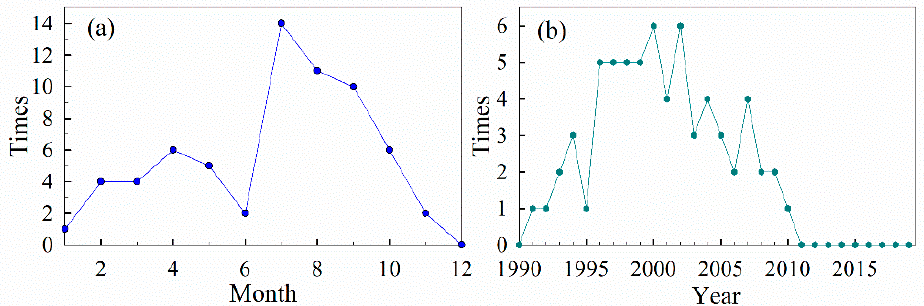
Figure 11. Number of advances of surging glaciers occurred in different ( a ) months and ( b ) years.